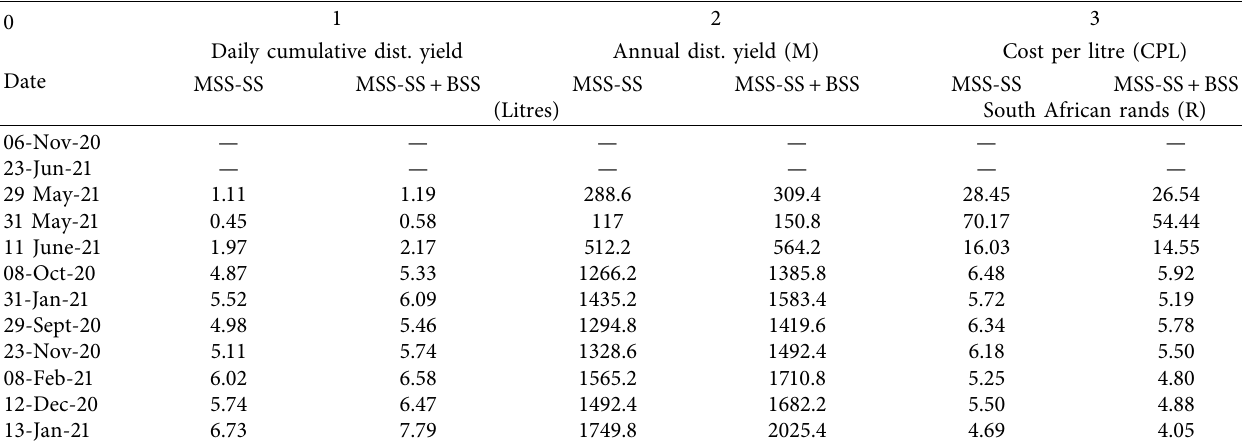
Table 5: CPL based on the daily distillate yield of the vapour-based MSS-SS. 0 1 2 3 Daily cumulative dist.